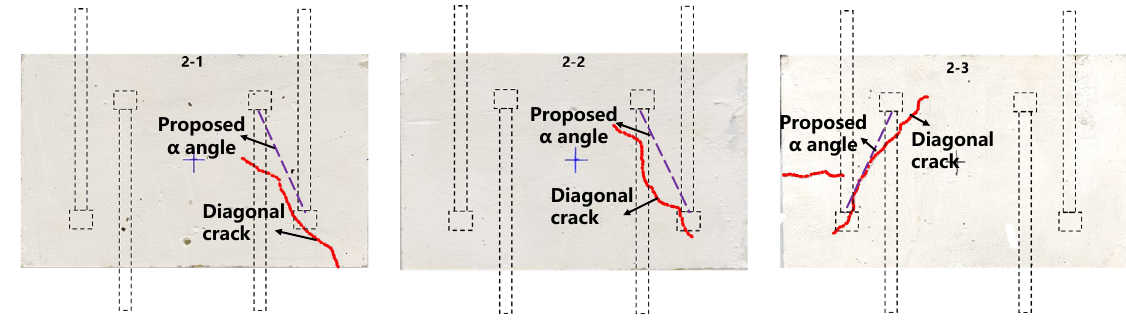
and the proposed a angle. It can be seen that the direction of the a angle matches with the the diagonal strut angle a . mine the diagonal strut angle a . mine the diagonal strut angle a .